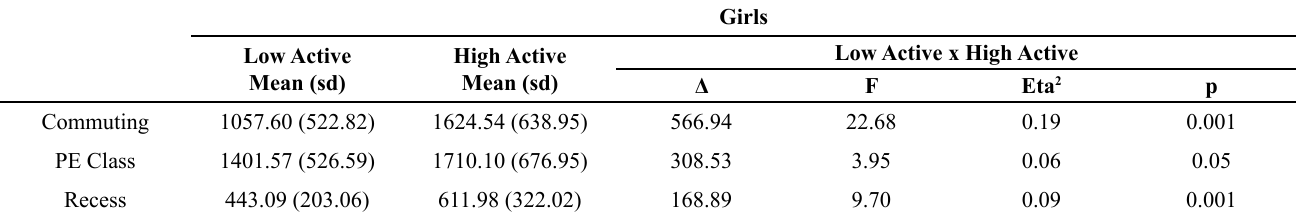
Table 3. Steps count of high active and low active adolescent